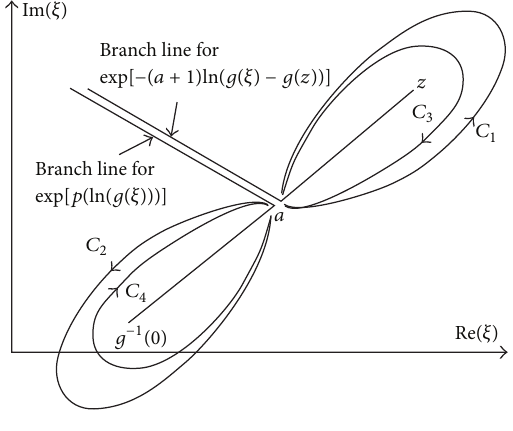
Figure 1: Pochhammer’s